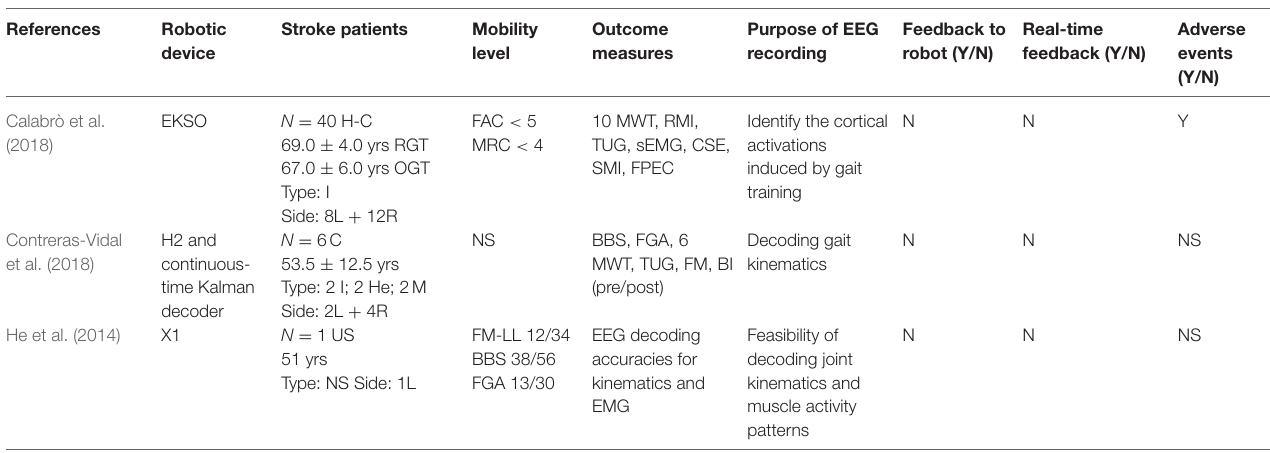
TABLE 1 | Electroencephalography (EEG)-based robotic studies (participants and